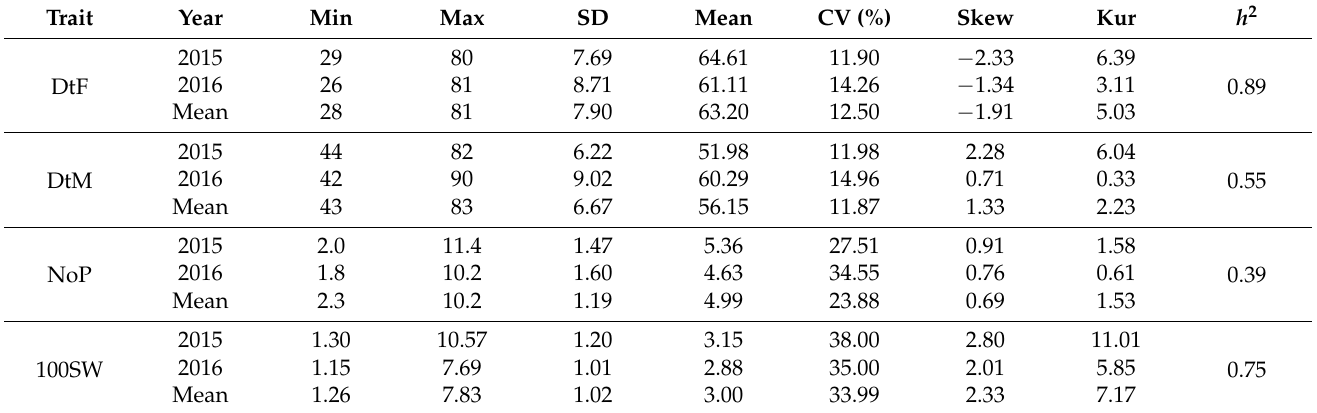
Table 1. Descriptive statistics for the agronomic traits in 2015 and